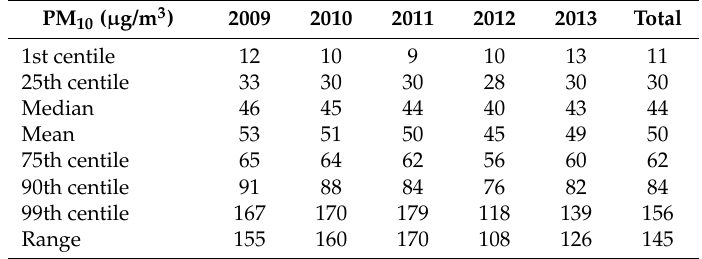
Table 2. Distribution of particulate matter less than 10 µ m (PM 10 ) between 2009 and 2013 in Korea.